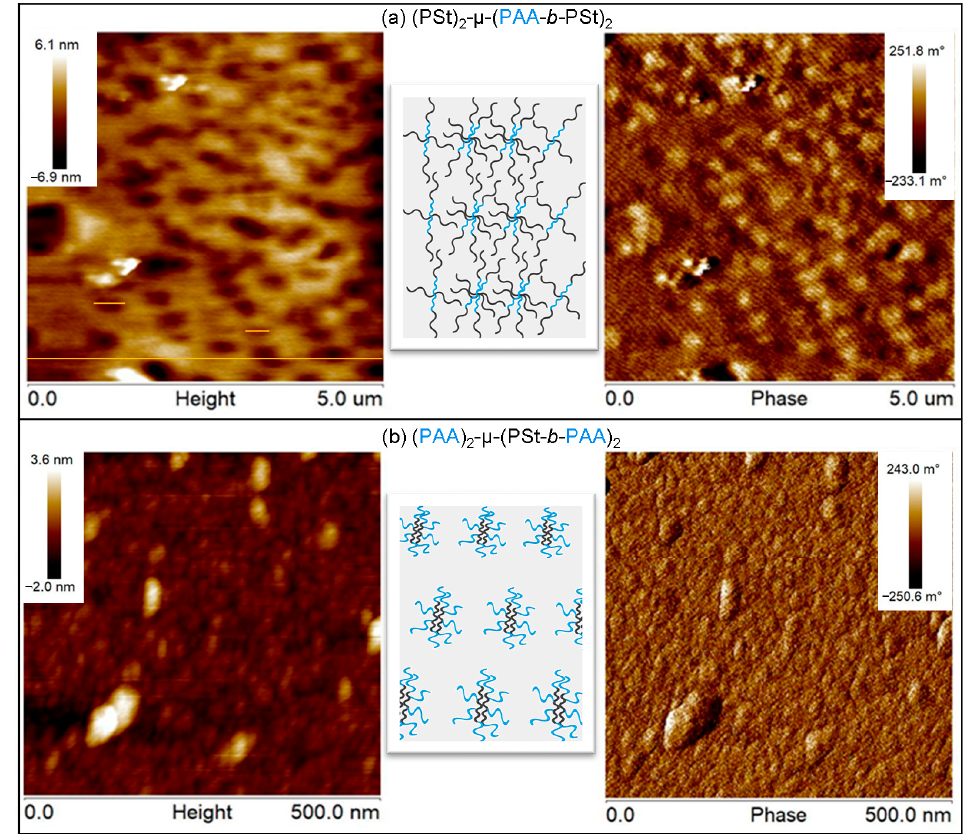
Figure 10. AFM height and phase images of ( a ) (PSt) 2 - μ -(PAA- b -PSt) 2 and ( b ) (PAA) 2 - μ -(PSt- b -PAA) 2 μ -stars.